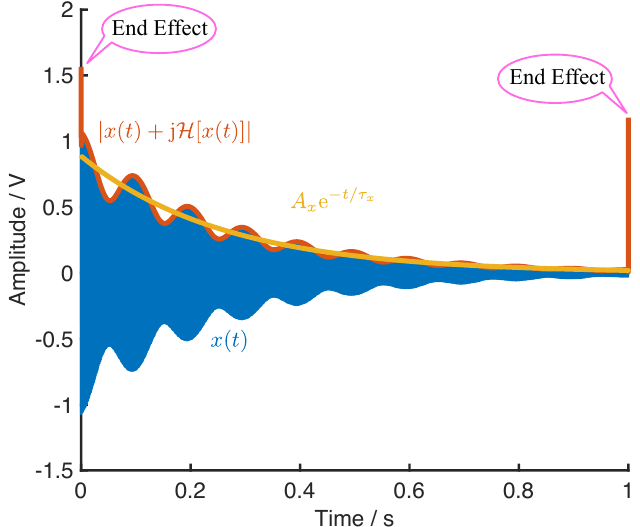
Figure 11. The ring-down beats and the envelope of the decayed